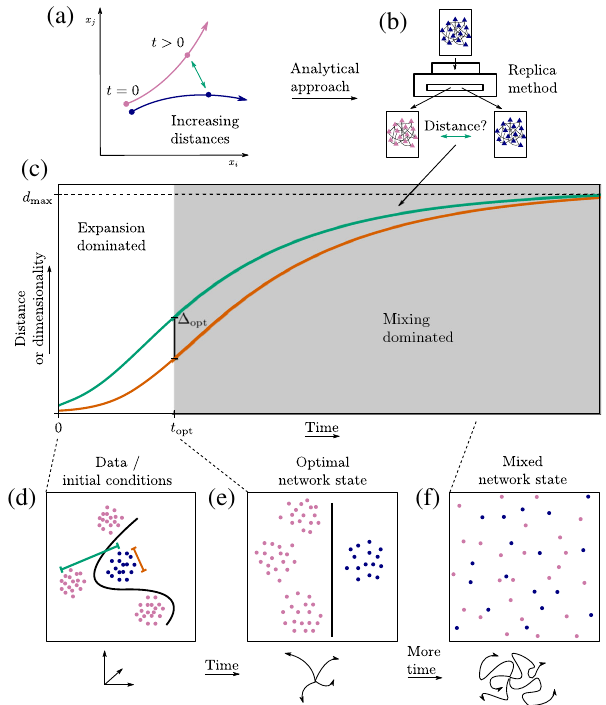
FIG. 1. Transient chaotic dimensionality expansion. The di- vergence of trajectories with different initial conditions in a chaotic network (a) can be computed by a replica calculation (b), leading to a curve describing the average temporal evolution of the distance (c). Sketch of linearly nonseparable data (d) supplied as initial condition to the dynamics (a). Chaotic dynamics expands the representation into spaces with increasing dimension (c). Interclass separation (green) initially grows quicker than variability within class (dark orange) up to point t of optimal opt separability (e). Subsequently, chaotic mixing causes separability to decline, ultimately leading to a completely mixed state